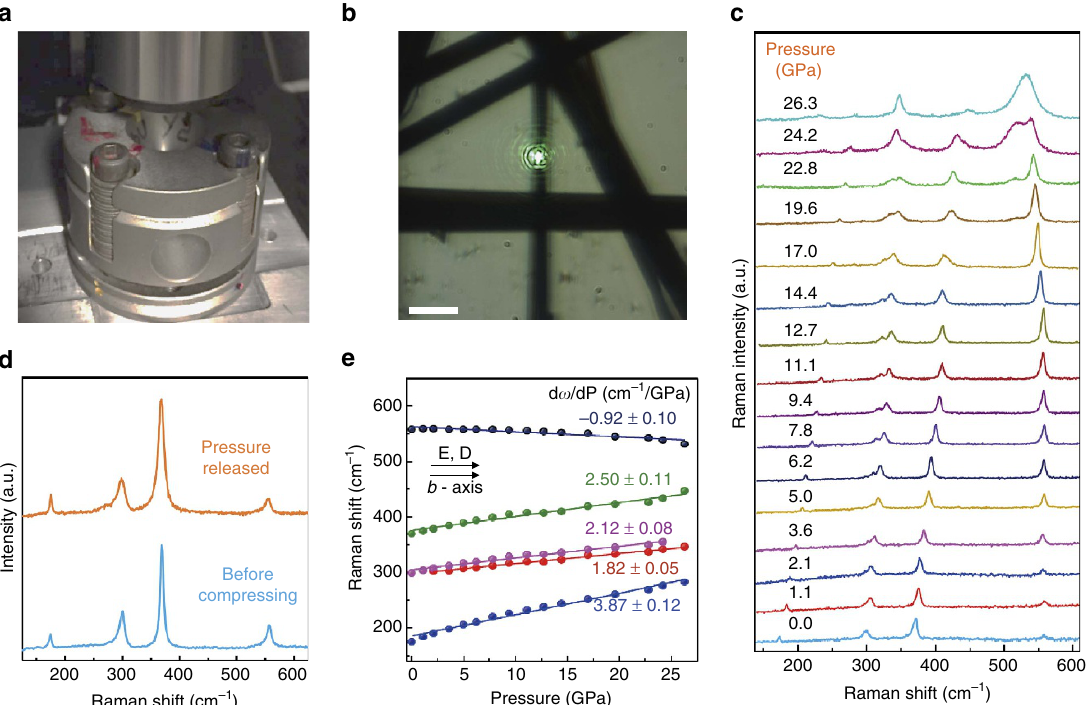
Figure 3 | The vibrational properties of TiS 3 under hydrostatic pressure. ( a ) Optical photograph of the DAC under (cid:3) 50 optical lens in the experiment. ( b ) Optical image of TiS 3 loaded inside the DAC. Scale bar, 1nm. ( c ) Raman spectra of TiS 3 under increasing hydrostatic pressure up to 26.3GPa; plots are offset for clarity. ( d ) A comparison between the Raman spectra of TiS 3 before applying pressure and after releasing pressure from 26.3GPa. ( e ) Raman peak position as a function of pressure. The excitation (E) and detection (D) polarization is in parallel to the b axis. The dependence can be described as o ( P ) ¼ o 0 þ (d o /d P ) P . The o 0 and d o /d P values are also shown in Table